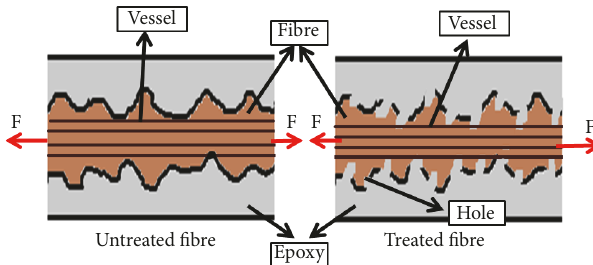
Figure 4: Behaviour of fibre in